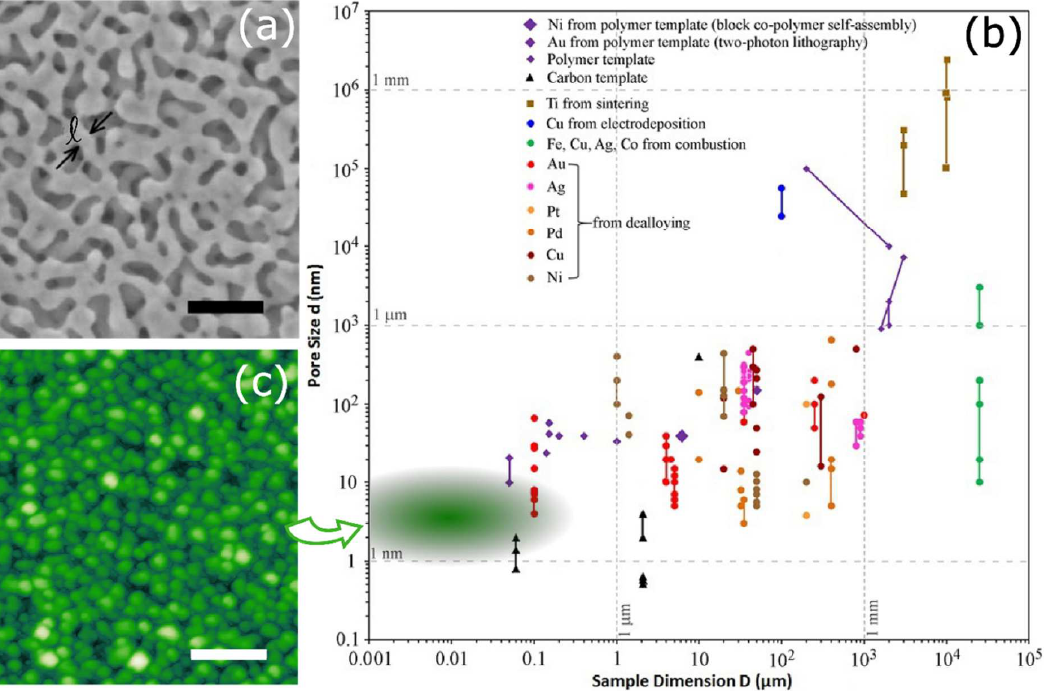
Figure 2. ( a ) Scanning electron micrograph of nanoporous gold with ligament size ℓ = 20 nm; scale bar = 100 nm (adapted from ref. [27], with permission from AIP Publishing). ( b ) Summary sample dimensions and pore sizes of nanoporous metal films fabricated by different synthesis methods. The green shaded area in the graph highlights the combination of possible pore sizes and film thickness obtainable by the gas-phase deposition discussed in this work. Adapted from ref. [1] under the Creative Commons Attribution License 4.0. ( c ) Representative AFM image of a nanogranular porous film at the same scale of panel ( a ). Scale bar = 100 nm, original